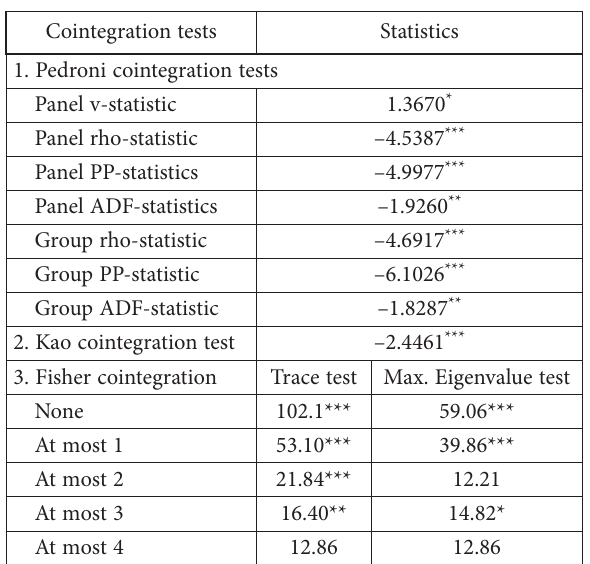
Table 4. Panel cointegration